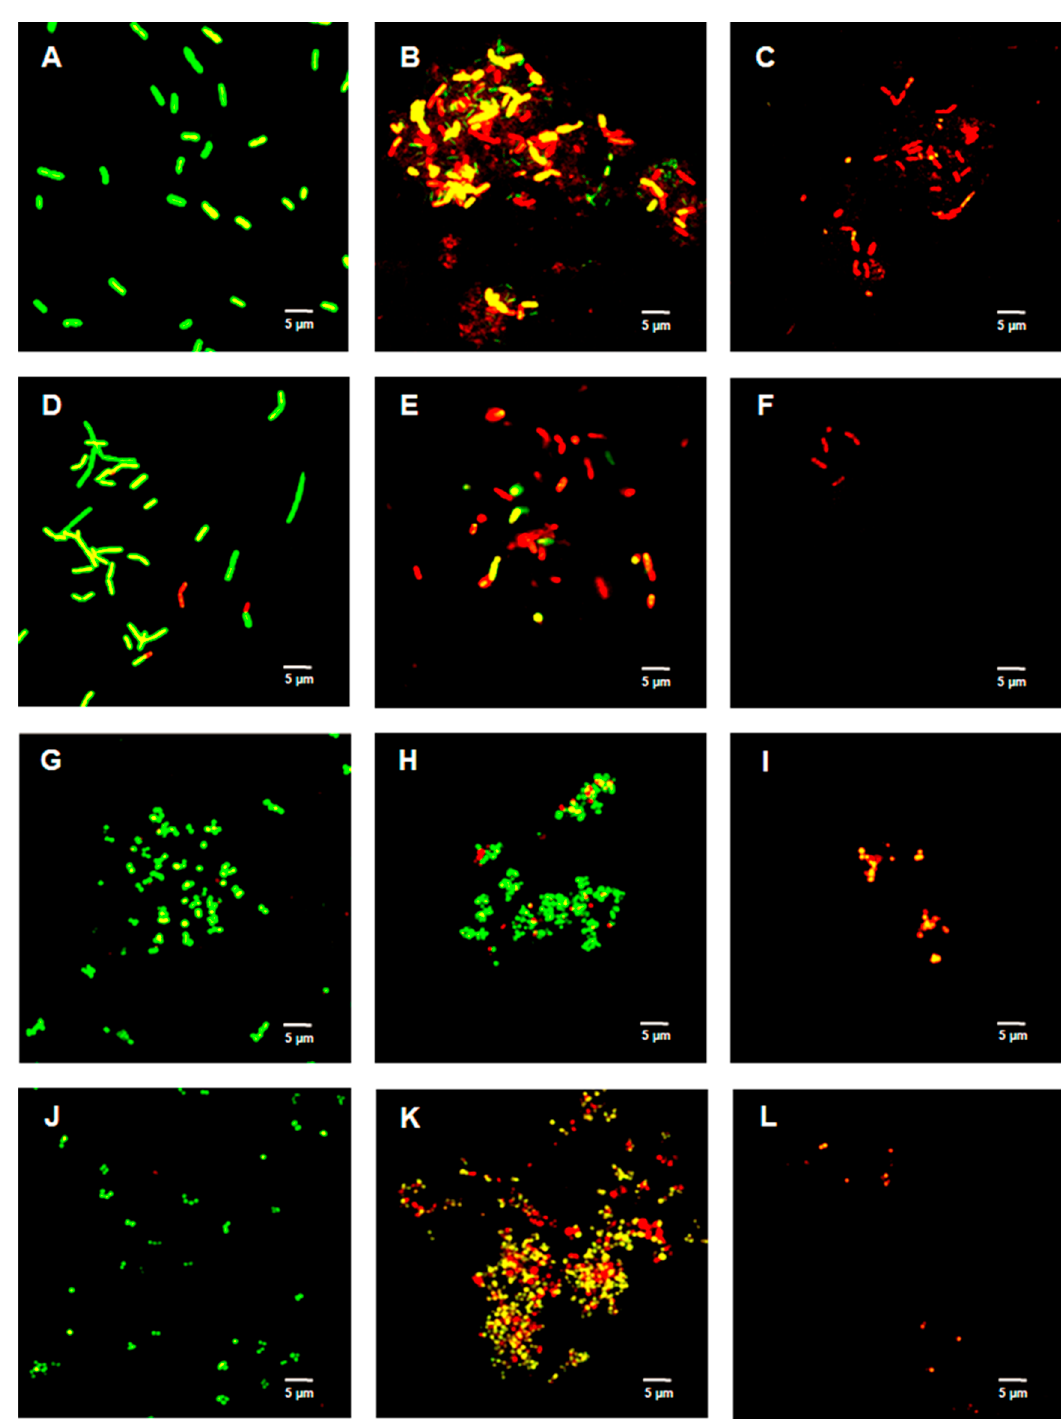
Figure 3. Live/Dead assay of Gram-positive species with various concentrations of TFDG at 6-h incubation. The samples were visualized using Olympus confocal microscope. The green indicates live bacteria, while the red indicates dead bacteria. ( A ) B. cereus control; ( B ) B. cereus with 62.5 µg/mL TFDG; ( C ) B. cereus with 250 µg/mL TFDG; ( D ) B. subtilis control; ( E ) B. subtilis with 62.5 µg/mL TFDG; ( F ) B. subtilis with 250 µg/mL TFDG; ( G ) S. aureus control; ( H ) S. aureus with 62.5 µg/mL TFDG; ( I ) S. aureus with 250 µg/mL TFDG; ( J ) S. pyogenes control; ( K ) S. pyogenes with 62.5 µg/mL TFDG; and ( L ) S. pyogenes with 250 µg/mL TFDG.